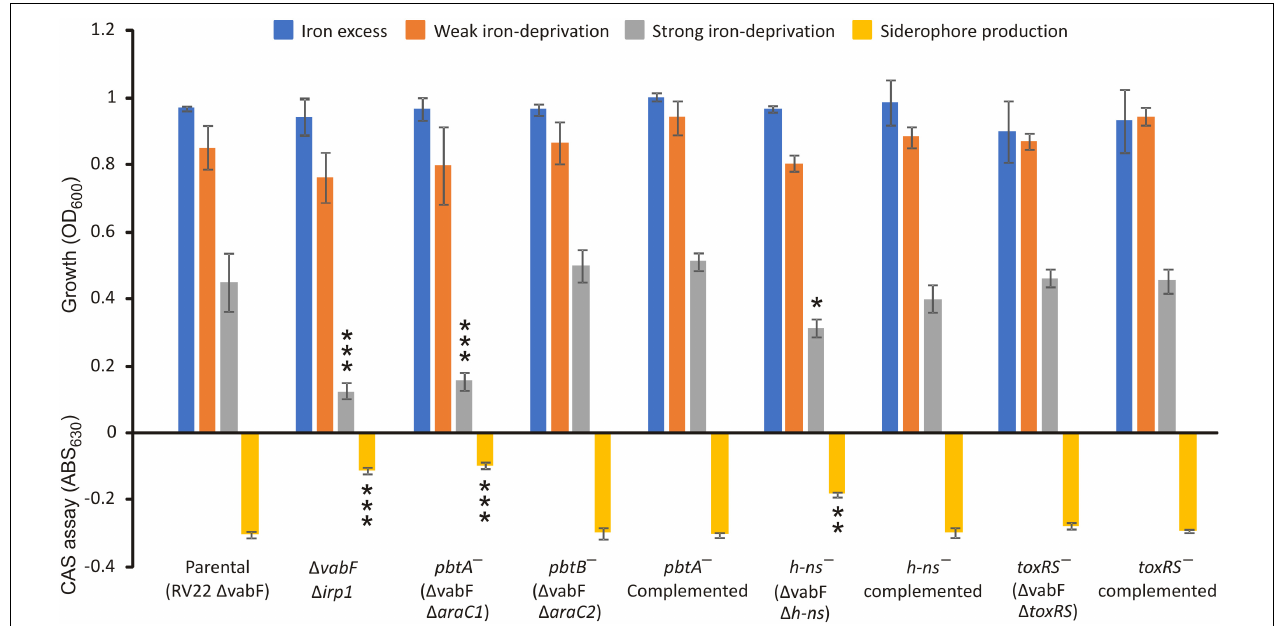
FIGURE 2 | Growth ability under different iron availability conditions of V. anguillarum parental strain compared to its derivative araC1 , araC2 , h-ns , and toxR-S defective mutants and complemented strains. V. anguillarum strains were cultured in CM9 minimal medium supplemented with 10 µ M FeCl 3 (iron excess conditions), or the iron chelator 2,2 (cid:48) -dipyridyl at 25 µ M (weak iron-deprivation), or at 75 µ M 2,2 (cid:48) -dipyridyl (strong iron deprivation). Siderophore production was evaluated in cell-free supernatants after growth of each V. anguillarum strain in weak iron deprivation (CM9 with 25 µ M 2,2 (cid:48) -dipyridyl) up to OD 600 ca. 0.8. t -test was used to detect significant differences between each mutant and the parental strain. * p < 0.05; ** p < 0.01; *** p < 0.001.